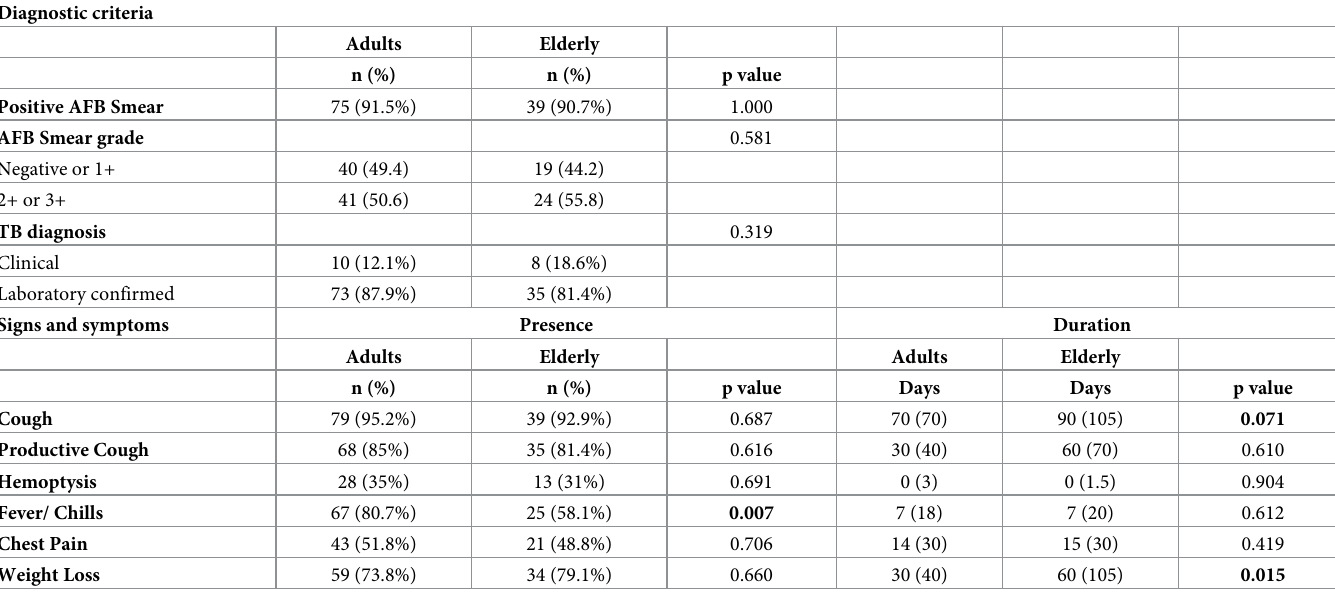
Table 4. TB diagnostic criteria and signs and symptoms, by age